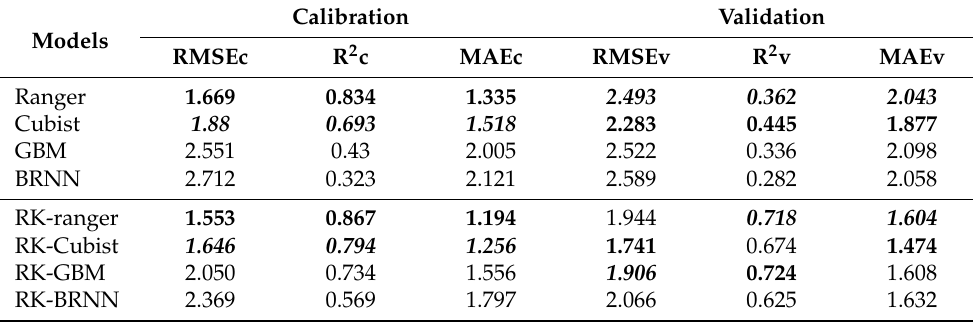
Table 4. Comparison of the prediction accuracy among different